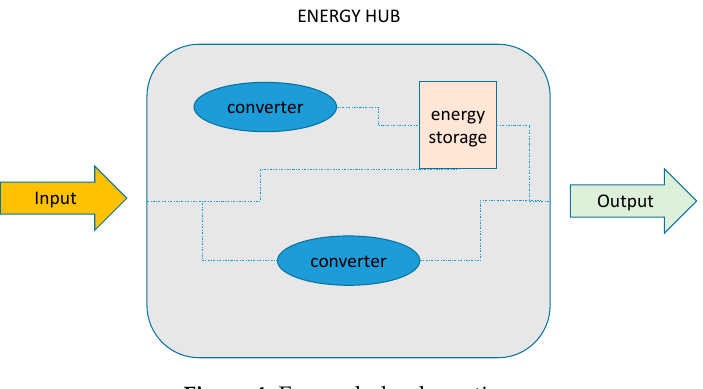
Figure 4. Energy hub schematics.